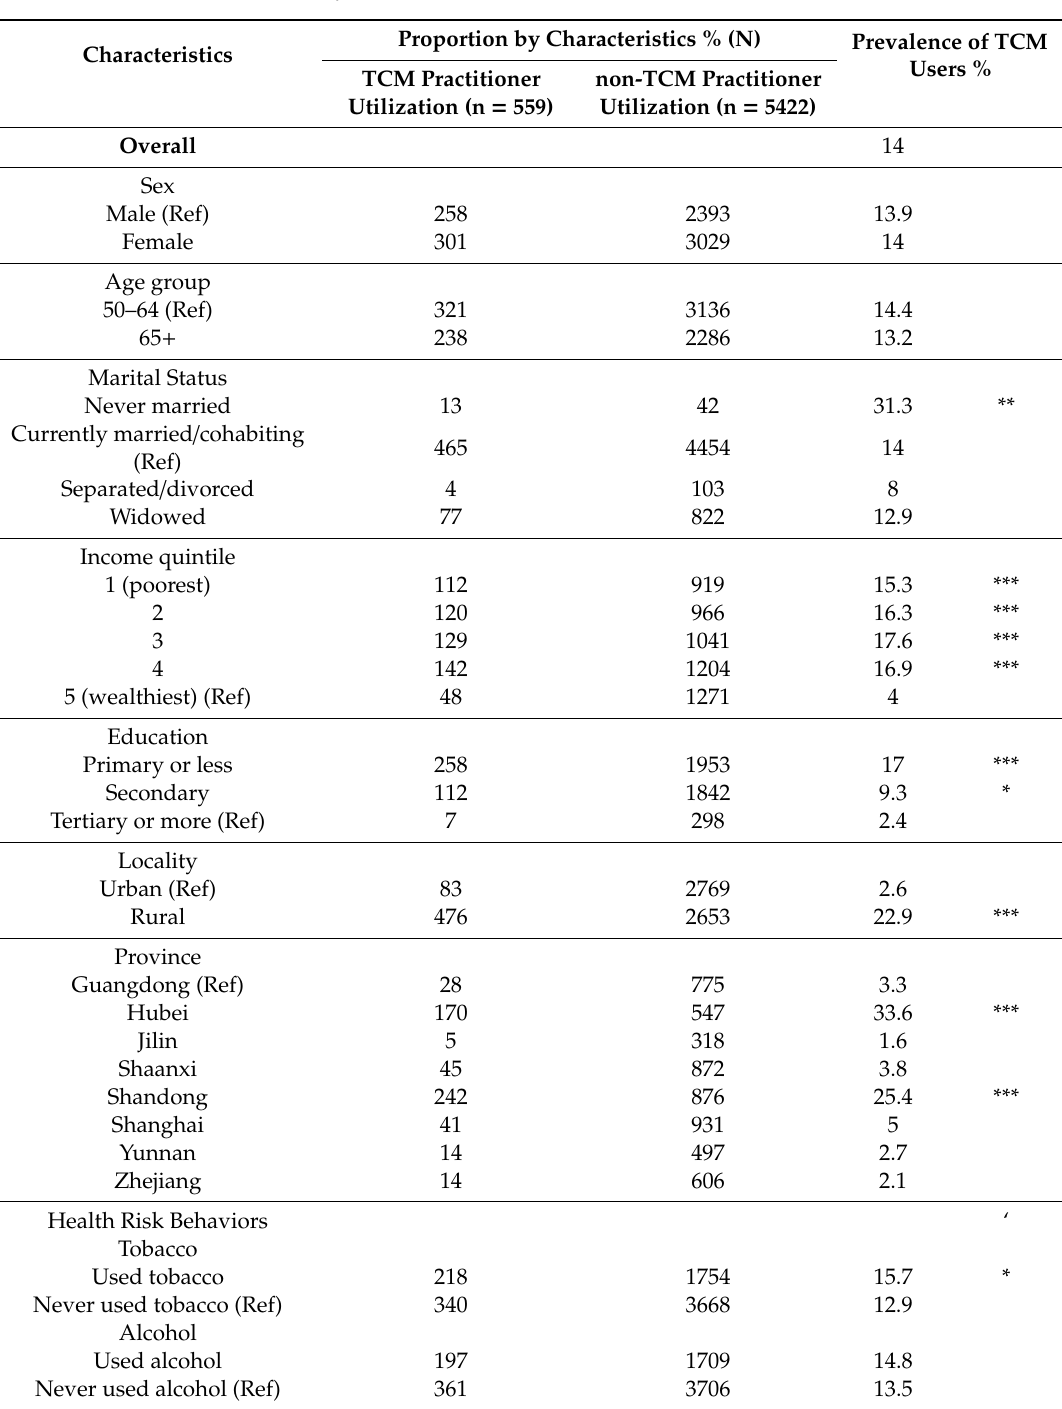
Table 1. Characteristics of participants that utilized and did not utilize TCM (traditional Chinese medicine) practitioners, World Health Organization (WHO) China Study on Global AGEng and Adult Health (SAGE) (Wave 1), surveyed from 2007 to